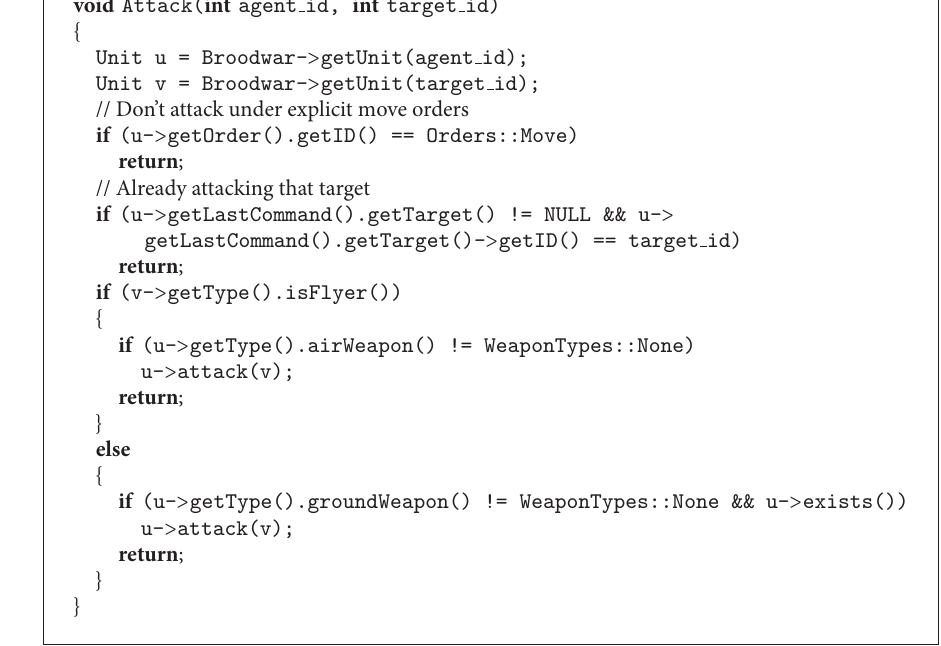
Algorithm 21: Implementation of the Attack conceptual control in BW. Because the targeting AI only selects targets the unit can attack, the test to see whether the unit is flying could be discarded.